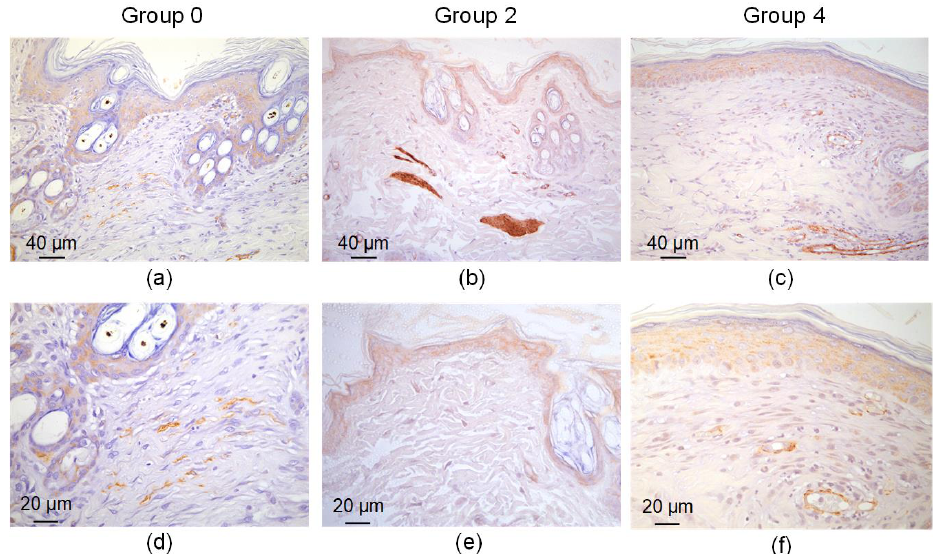
Figure 8. α -SMA expression in defect sites treated with simple sutures ( a , d ), laser soldering with BSA+ICG (group 2) ( b , e ) or BSA+ICG+SWCNT (group 4) ( c , f ) 10 days after the operation.